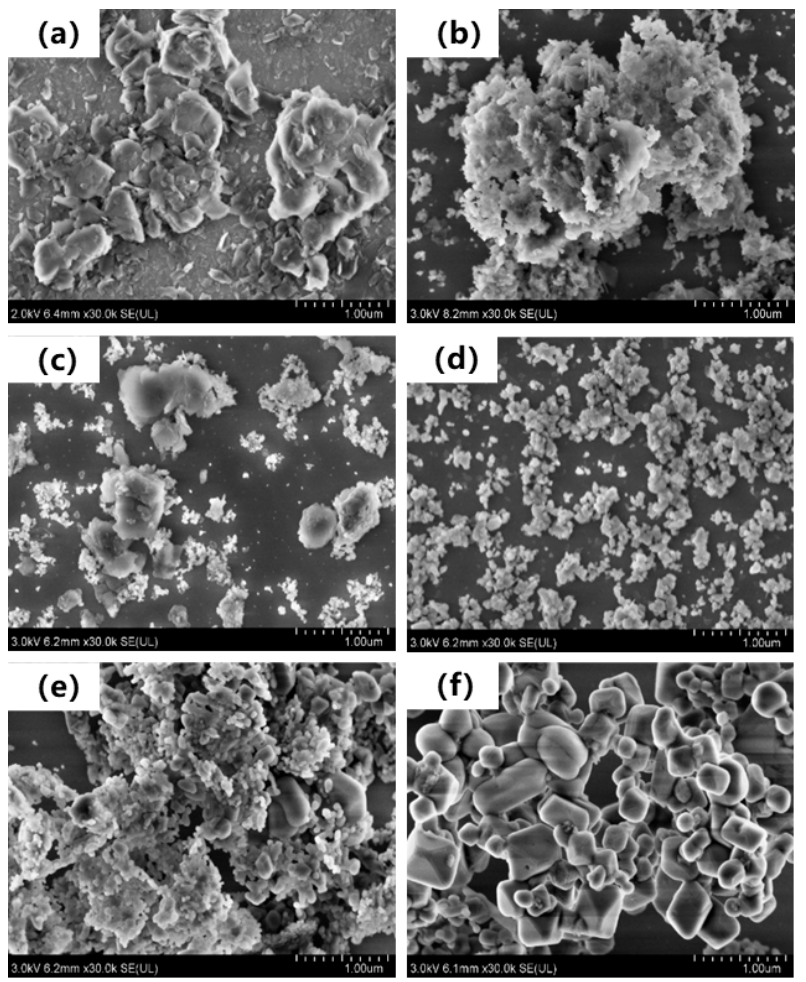
Figure 6. SEM images of the magnesium residue calcined at different temperatures. ( a ) 0 °C. ( b ) 400 °C ( c ) 500 °C ( d ) 600 °C ( e ) 700 °C ( f ) 800 °C.